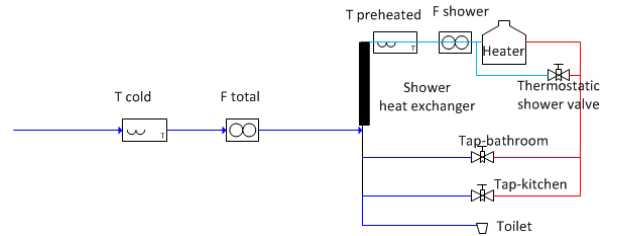
Figure 2. Project setup diagram (F is flow meter, T is temperature sensor).